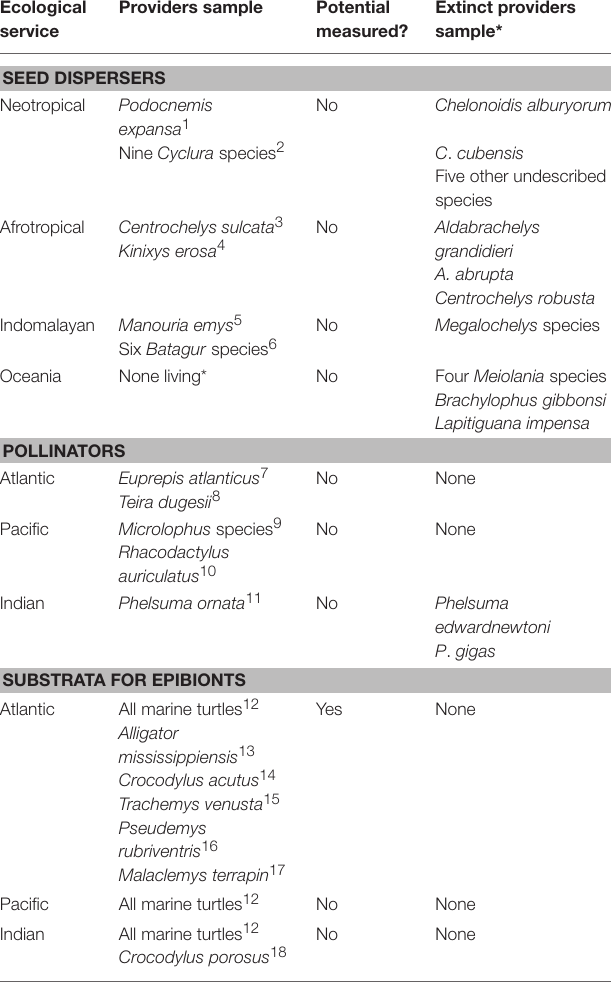
TABLE 1 | Examples of large tropical reptiles as gene transporters. Ecological